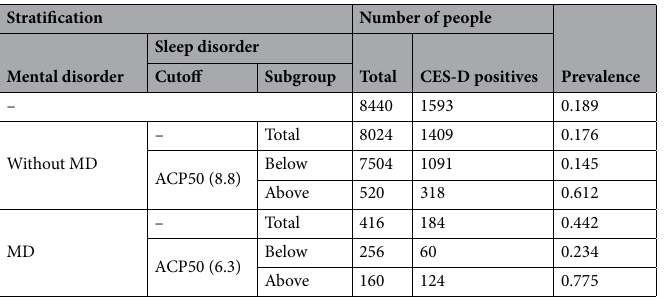
Figure 1. ( A ) Probit regression model of estimated prevalence of Center for Epidemiologic Studies Depression (CES-D) in subgroups stratified by history of mental disorder. The subgroup without MD, P (CES-D positive | AIS = x, mental disorder = 0), is shown in green, while that with MD, P (CES-D positive | AIS = x, mental disorder = 1), is in orange. An estimated prevalence of 50% is shown by the horizontal dotted line, as well as AIS score with a 50% of CES-D prevalence (ACP50), which is the intersection of this line with the graphs representing each model. ( B ) Scatter plot of the estimated and observed prevalence of CES-D positivity at AIS score. Each point indicates the respective AIS score (Supplementary Table 3). The correlation coefficient was R = 0.962, p < 0.01 for the subgroup with MD, and R = 0.962, p < 0.01 without MD. Stratification Number of